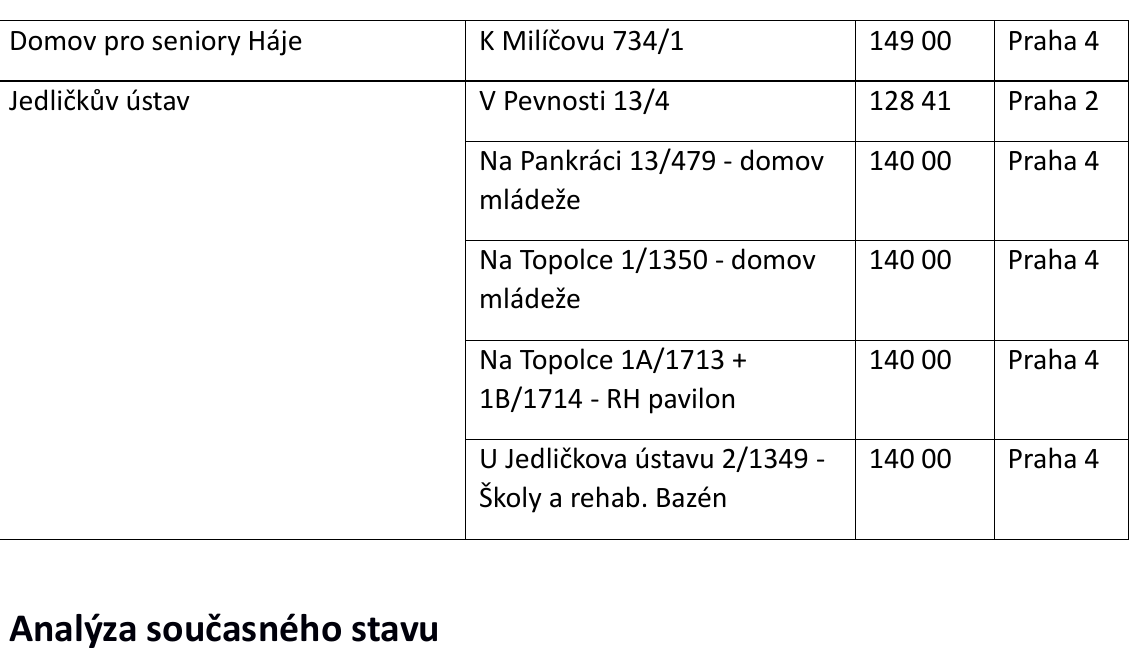
Tab 5: Technické parametry vybraných objektů